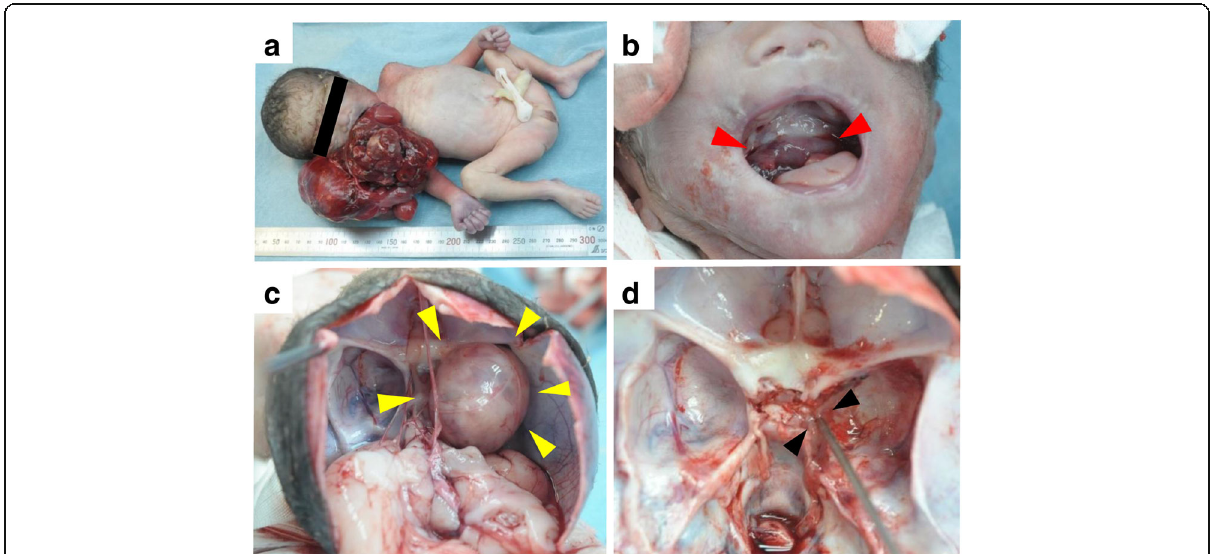
Fig. 2 Macroscopic findings at autopsy. a The epignathus, a large reddish multicystic tumor is seen protruding from the mouth. b There is a defect in the soft palate within which the base of the epignathus is located (red arrowhead). c The intracranial tumor is covered by a thin capsule (yellow arrowhead) and there is no invasion of the brain. d After removal of the stem of the intracranial tumor, a small hole, measuring 2 mm in diameter, is detected on the right side of the sella turcica. A communication can be seen between the epignathus and the intracranial tumor through this hole (black